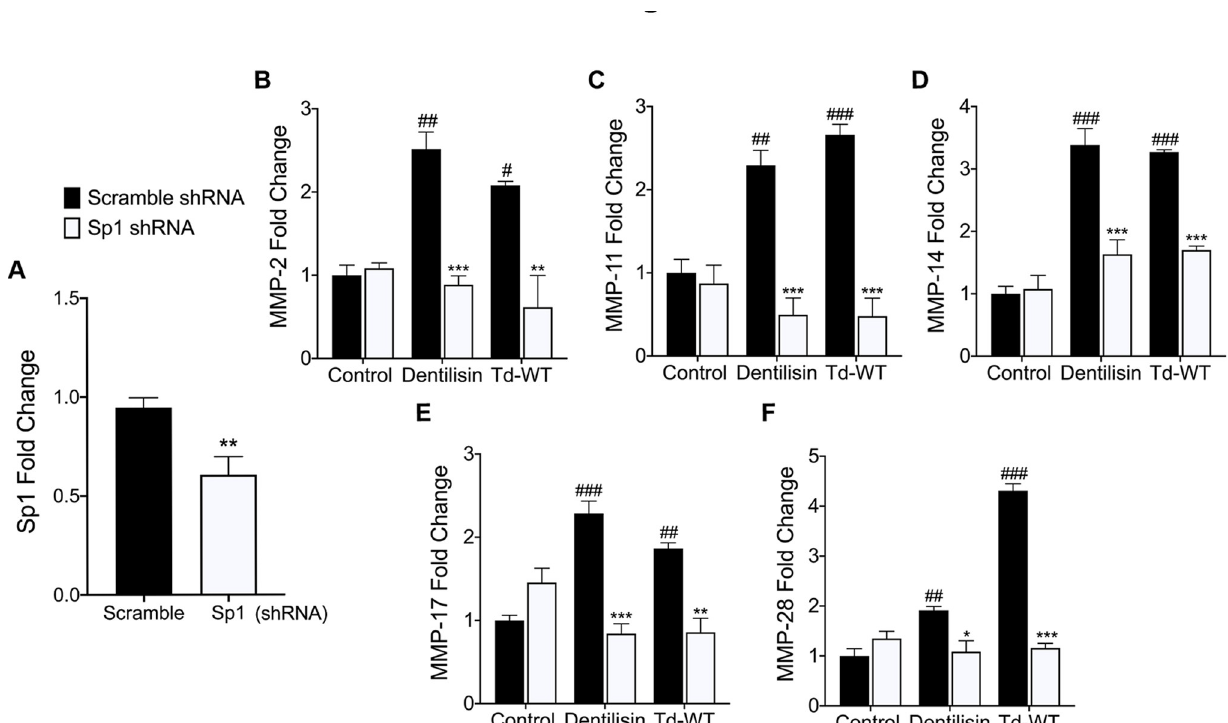
Fig 9. Stable Suppression of Sp1 inhibits T . denticola -stimulated upregulation of MMP 2 , 11 , 14 , 17 and 28 in hPDL cells. A) RT-qPCR validation of stable gene suppression using shRNA vectors targeted against Sp1 in healthy hPDL cells. Cells transduced with scrambled shRNA vectors were used as a control. Statistical significance was determined using an unpaired t-test. Bars represent ± SEM of mean values (n = 3 clones). �� p < .01 versus control. B-F) RT-qPCR for MMP-2 , MMP-11 , MMP-14 , MMP-17 and MMP-28 mRNA expression of scrambled shRNA control and Sp1 shRNA hPDL cells challenged or stimulated with purified dentilisin at a concentration of 1 μ g/mL or Td-WT at an MOI of 50 for 2-hours in alpha-MEM media supplemented with 10% FBS and no antibiotics followed by a 22-hour incubation in alpha-MEM media supplemented with 10% FBS, 1% Pen/Strep and 1% Amphotericin B. The expression of each gene was normalized to that of GAPDH . Statistical significance was determined using a Two-Way ANOVA followed by post-hoc Tukey’s multiple comparisons. Bars represent mean ± SEM (n = 3). # p < .05 versus scramble control group. ## p < .01 versus scramble control group. ### p < .001 versus scramble control group. � p < .05 versus Sp1 shRNA equivalent group. �� p < .01 versus Sp1 shRNA equivalent group. ��� p < .001 versus Sp1 shRNA equivalent group.